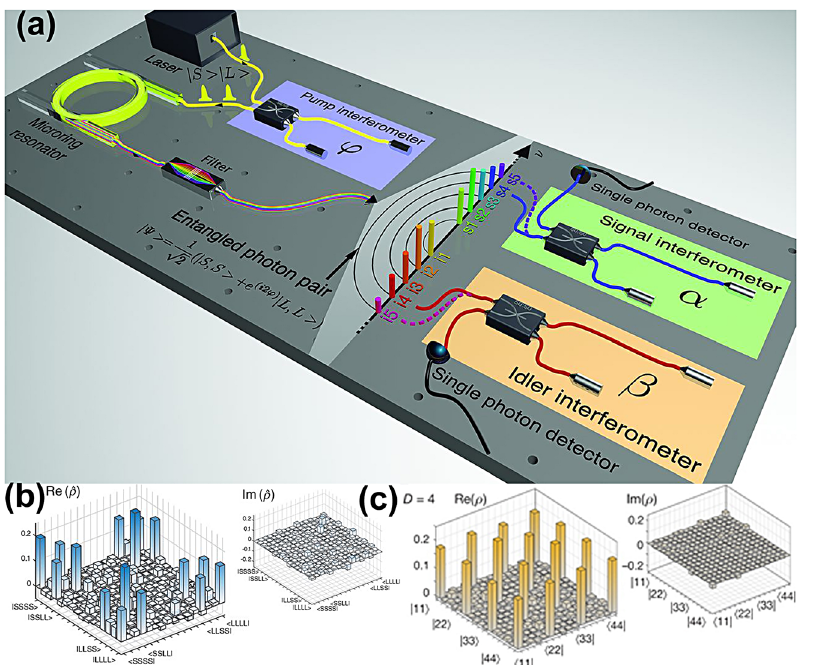
(Figure 12a and b). The micro-ring resonator of this QOFC was pumped with a passive mode-locked fi ber laser with a repetition rate of 16.8 MHz and a pulse width of 570 ps. A stabilized unbalanced fi ber interferometer with an 11.4 ns delay was used to generate time-bin – entangled qubits where double pulses of equal power were produced with a de fi ned relative phase difference [249]. Further, on chip generation of the higher-dimensional entangled states is also being realized where the photons were created in a coherent superposition of multiple high-purity frequency modes (Figure 12c) [240, 243, 250].